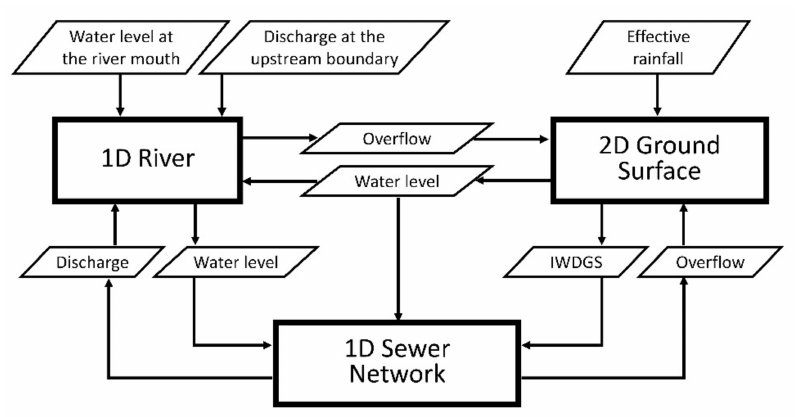
Figure 1. Schematic chart of the urban flood model (Wu et al., 2022)